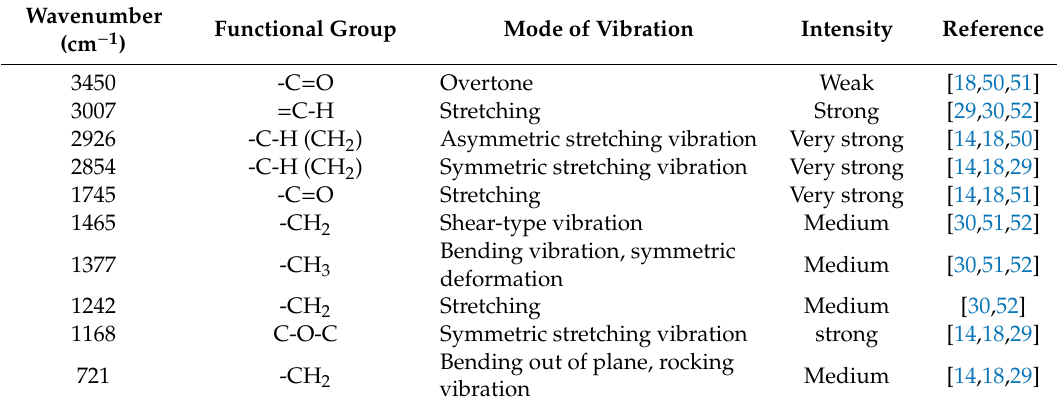
Table 7. Properties of absorption peaks for HRNO and HRNOB.